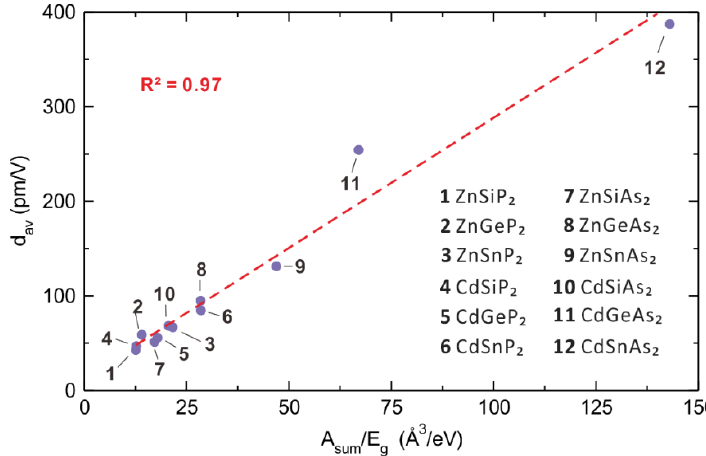
/ E av ) and A sum g